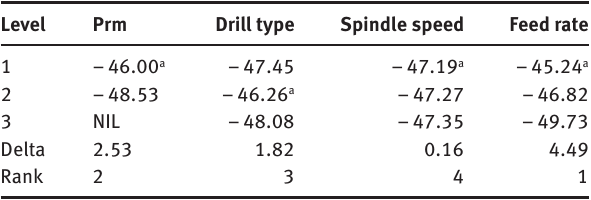
Table 5: Response table for S/N for thrust force.